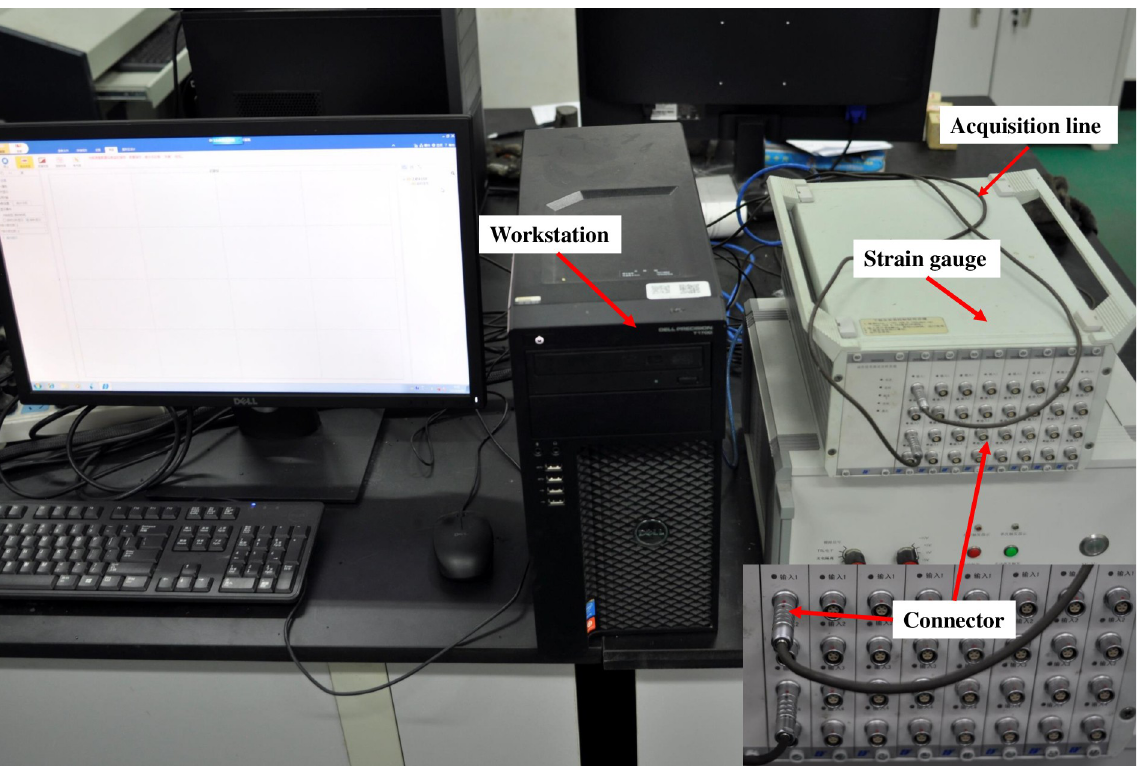
Fig 10. DH5929 strain